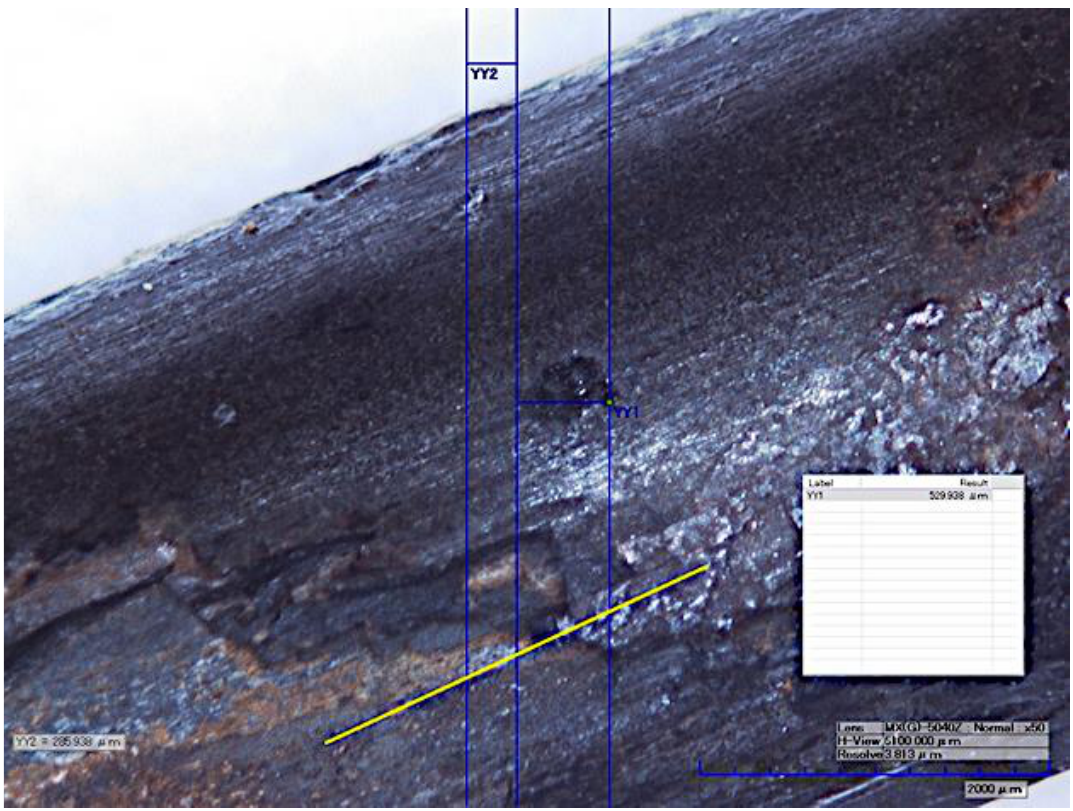
Figure 4. The width of the smallest determined corrosion damage. The yellow line marks observation path on HIROX 2000.